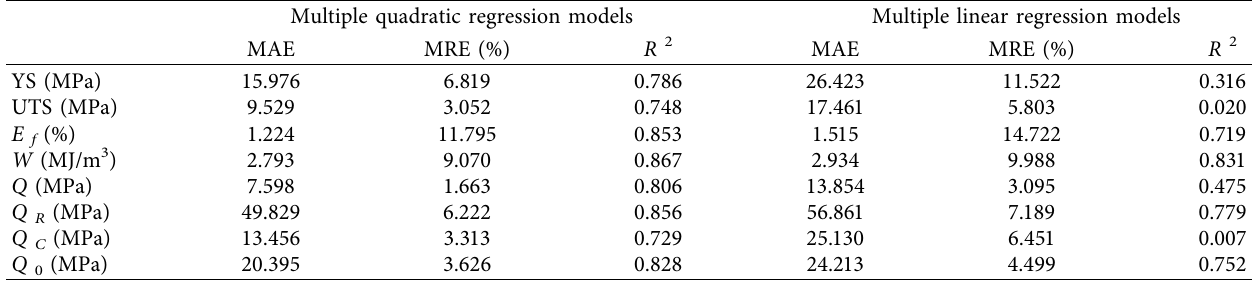
Table 2: Comparison result of the multiple quadratic and linear regression models for tensile mechanical properties and quality indices of A357.